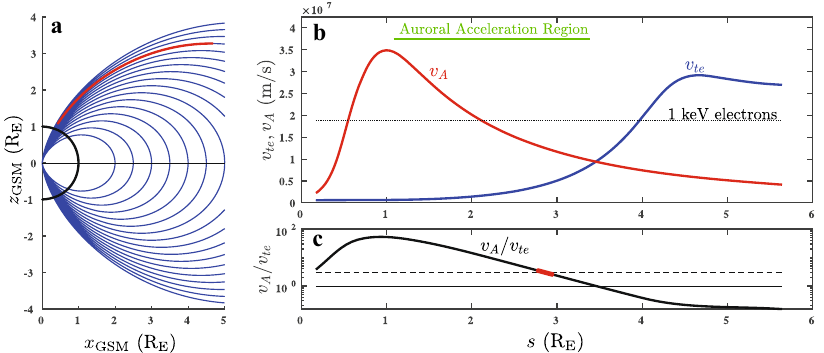
Fig. 5 Model of the auroral zone. a Plot of the Earth ’ s dipole magnetic fi eld lines (blue) and the segment (red) along the fi eld line through the auroral acceleration region for L = 8.5 (or invariant latitude Λ = 70 ∘ ). Pro fi les of ( b ) the Alfvén speed v A (red) and electron thermal velocity v te (blue) as well as ( c ) their ratio v A / v te (black) as a function of distance along the fi eld line s . The dashed line shows the ratio v A / v te ≃ 3 relevant to the LAPD experiments reported here. The highlighted red region shows the experimental v A / v te corresponds to v A / v te in the auroral zone near a distance s of 3 R or invariant latitude λ = 70 ∘ . In Fig. 5, we show (a) the inner